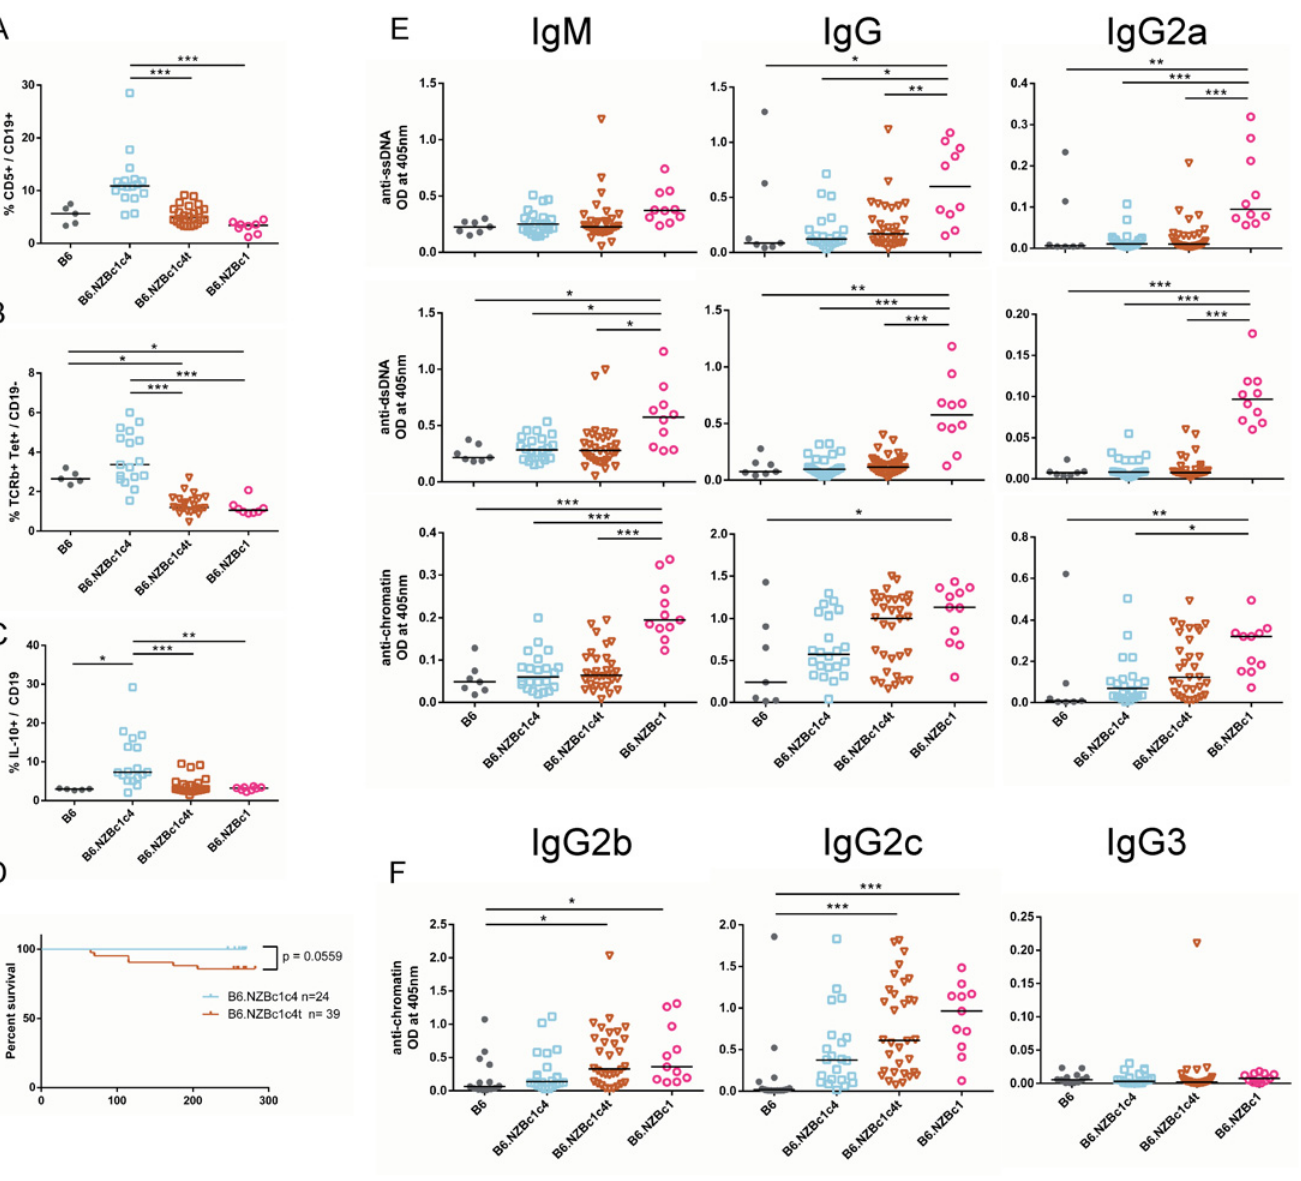
Fig 2. Suppression of anti-ssDNA and – dsDNA autoantibody production in bicongenic B6.NZBc1c4(123 – 151) mice in the absence of either CD5 + B cells or splenic NKT cell expansion. Frequencies of splenic CD5 + B cells (A), NKT cells (B), and IL-10 competent B cells (C) were measured by flow cytometry in 8 to 10 month old mice. (D) Survival curves of aged B6.NZBc1c4 and B6.NZBc1c4t mice show a trend (p = 0.0559) towards increased mortality in B6.NZBc1c4t mice. Levels of anti-ssDNA, -dsDNA, and – chromatin IgM, IgG and IgG2a (E) were measured by antigen-specific ELISA. To define the high levels of anti-chromatin autoantibodies in B6.NZBc1c4(123 – 151) mice, IgG2b, IgG2b, and IgG3 anti-chromatin antibodies were measured by ELISA (F). Each point represents a single mouse, with the lines for each group representing the median. Statistical analyses were carried out using a Kruskal-Wallis test with Dunn multiple comparison posttests between all groups. * P < 0.05, ** P < 0.01, *** P <